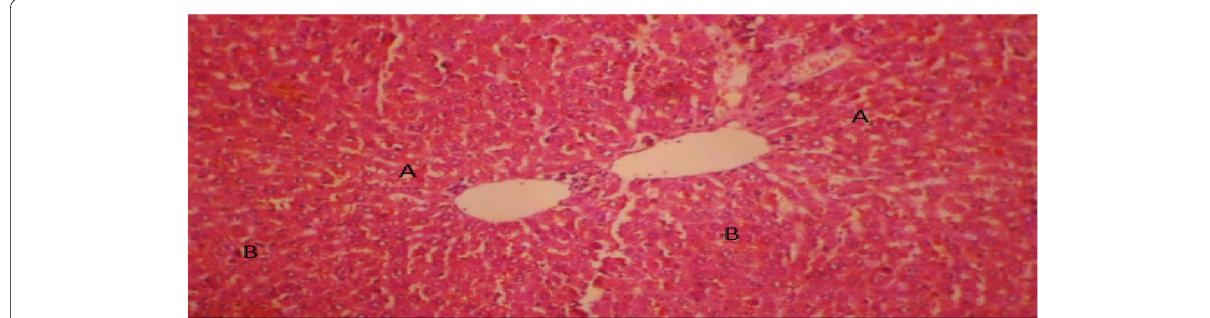
Fig. 10 Liver section of rat co-administered SA and 400mg/kg leaf extract for 14 days (Group 8) showing: A , mild haemorrhagic necrosis and B , moderate Kupffer cell activation (H&E x 100)